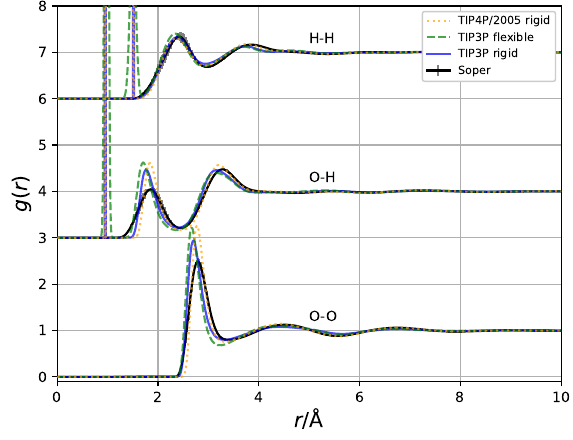
Figure 4. RMSD averaged over all atoms compared to the long- time expectation given by the macroscopic di ff usion coe ffi cient of